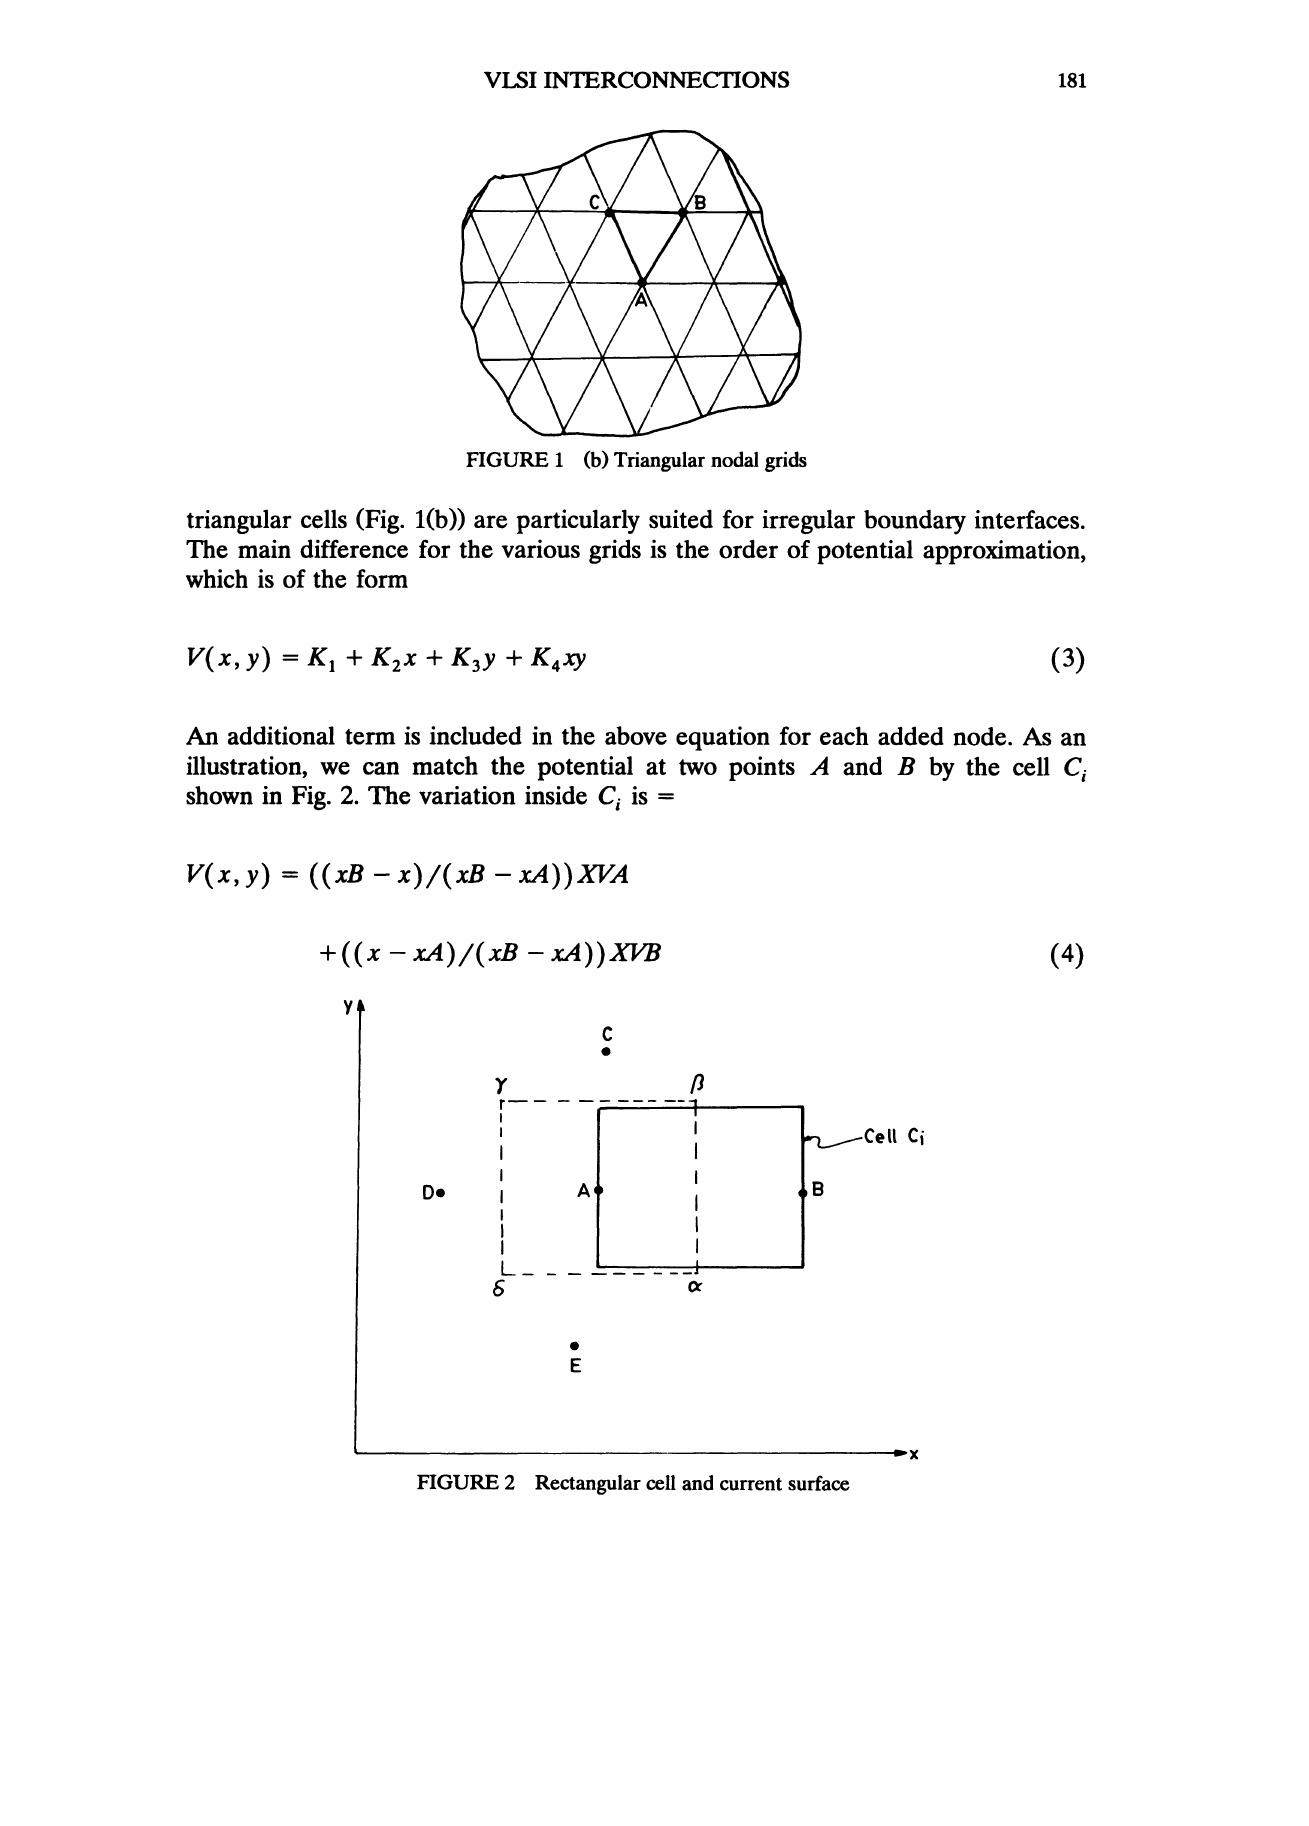
FIGURE 2 Rectangular cell and current